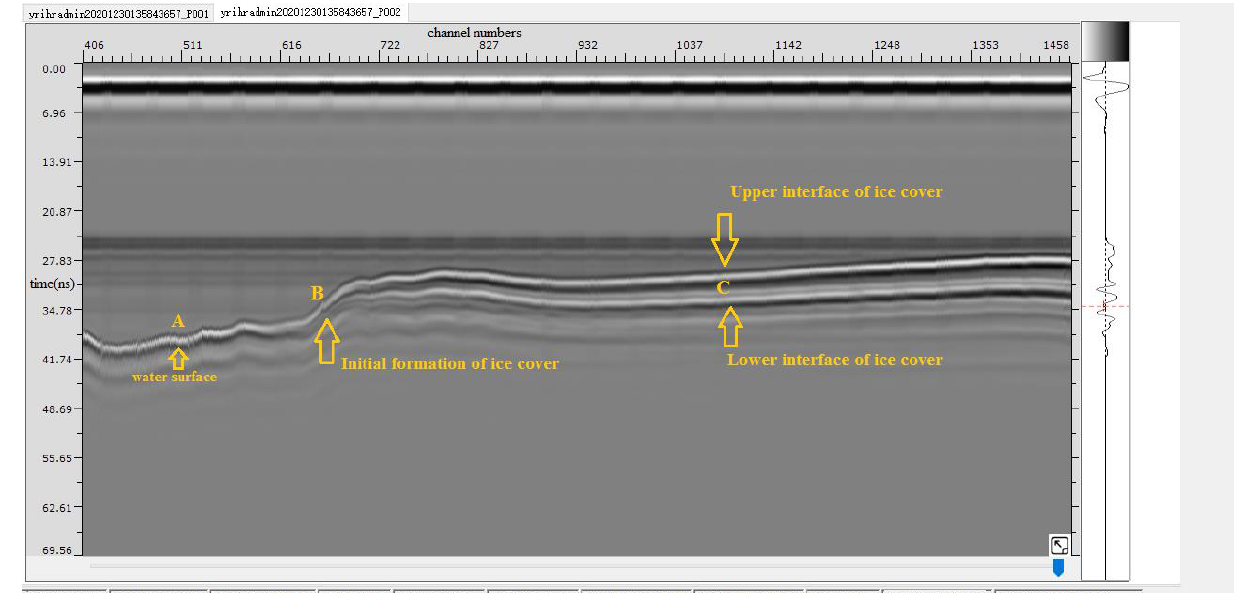
Figure 10. Detected radar spectrums of the Shisifenzi reach in the 2020–2021 ice period.